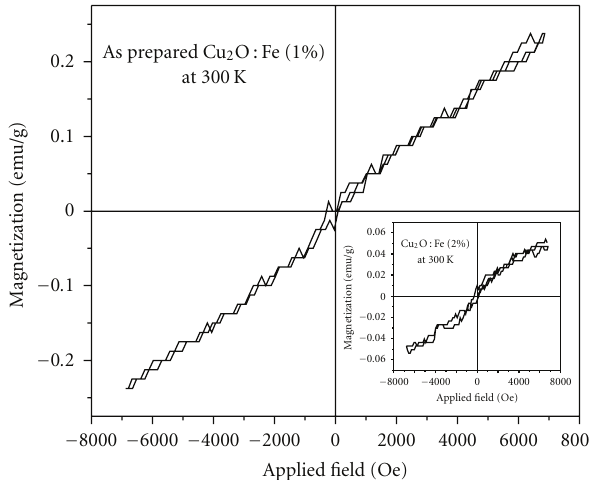
Figure 16: Paramagnetic behavior of 1% Fe-doped Cu 2 O at 300K. Inset shows the same for 2% “Fe”-doped Cu 2